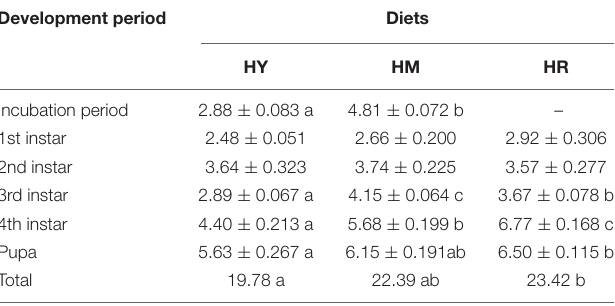
TABLE 1 | Development period in days (mean ± the standard error of the mean) of H. axyridis (Pallas, 1773) fed with three different diets: (1) HY, A. pisum ; (2) HM, D. citri ; (3) HR, artificial diets; at 25 ± 1 ◦ C, 70 ± 5% RH and a photoperiod of 16L:8D.